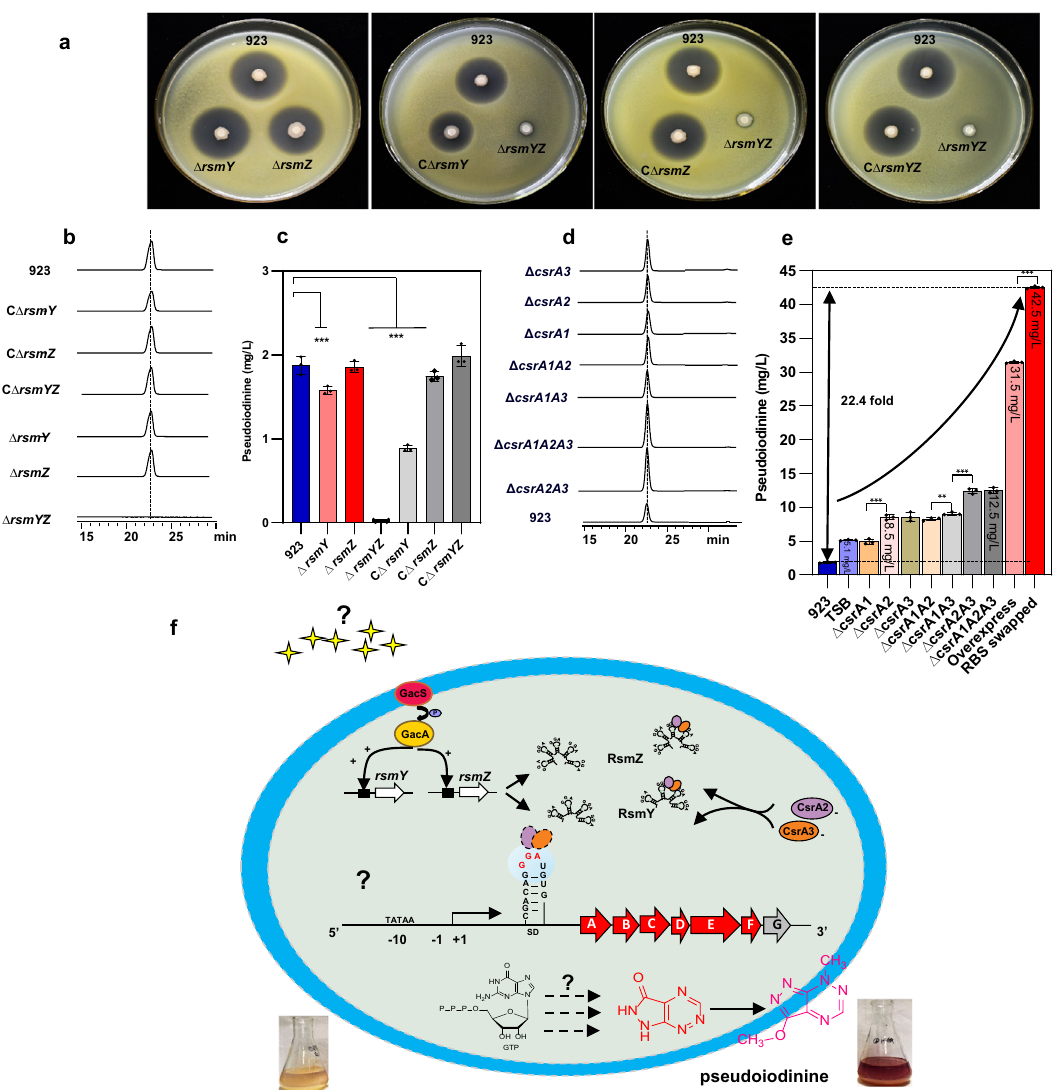
Fig. 5 | GacA and CsrA mediate the biosynthesis of pseudoiodinine. a Antibacterial activity assays of P. mosselii 923, Δ rsmY , Δ rsmZ , and Δ rsmYZ mutant and complemented mutants C Δ rsmY , C Δ rsmZ , and C Δ rsmYZ . Panels b , d , HPLC pro fi les (Method B, detected at 500nm) of the mutants and com- plemented strains compared with the wild-type 923. Panels c , e , pseudoiodinine production by different strains. The numbers on y -axes show pseudoiodinine yields. c The wild-type 923, rsmY , rsmZ , and rsmYZ mutants and their corre- spondingcomplementedstrainsinLBmedium.Errorbarsshowmeans±SD( n =3 biological independent replicates) and signi fi cant differences at *** P <0.001, *** P =0.0002, = 2.5×10 − 14 , = 1.5×10 − 10 in sequence. e Pseudoiodinine yields in wild-type P. mosselii 923 in LB and TSB medium, the csrA1 , csrA2 , csrA3 , csrA1A2 , csrA1A3 , csrA2A3 and csrA1A2A3 mutants, and overexpressing and RBS-swapped strainsin TSBmedium. Errorbars showmeans±SD ( n =3biologicalindependent replicates) and signi fi cant differences at *** P <0.001, ** P <0.01, ** P =0.005,